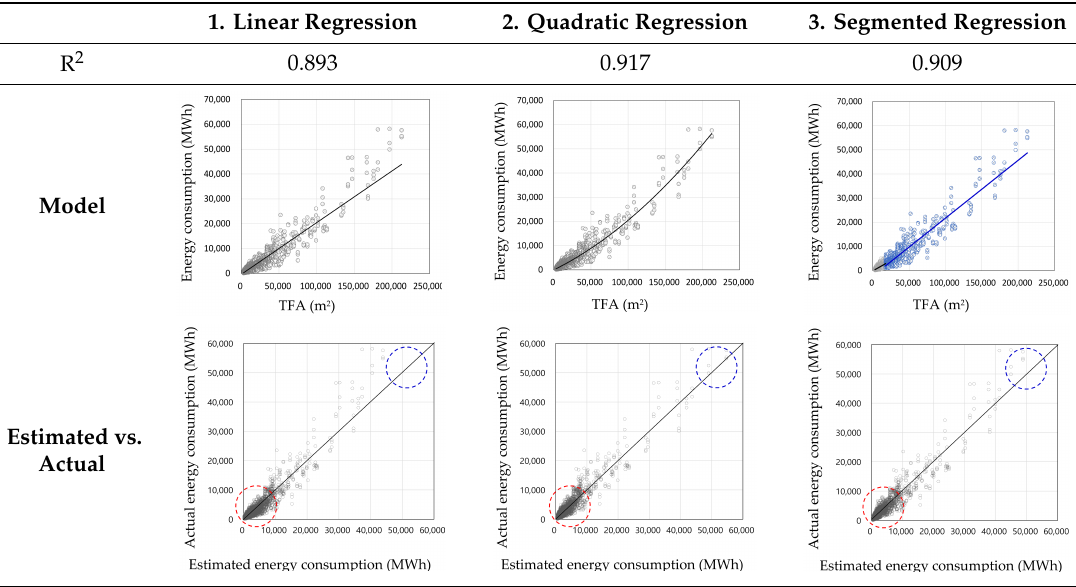
Table 8. Comparison results by type of regression analysis for case D.